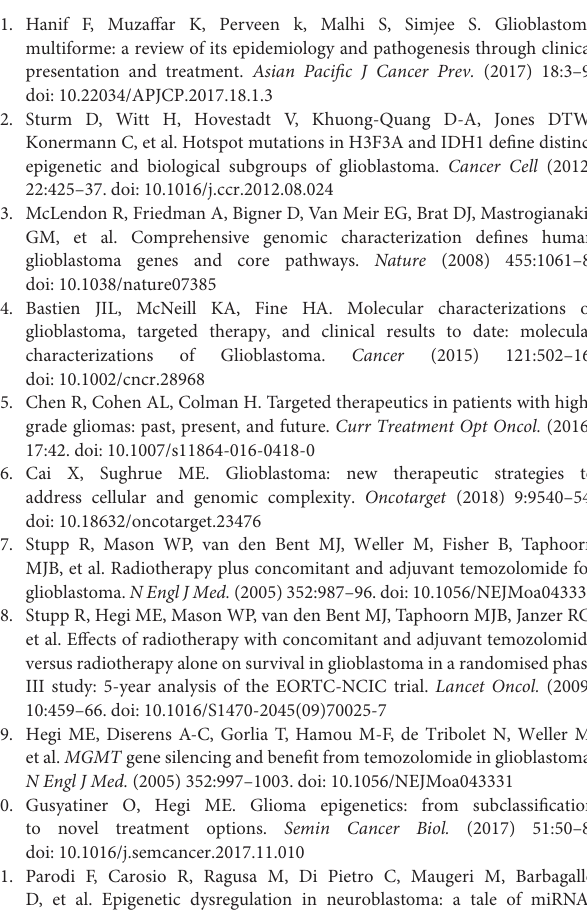
Supplementary Figure 1 | IDH1/2 pathways. Metabolic pathways involving IDH1 (cytoplasmic) and IDH2 (mitochondrial). IDH1/2 (wt) converts Isocitrate into